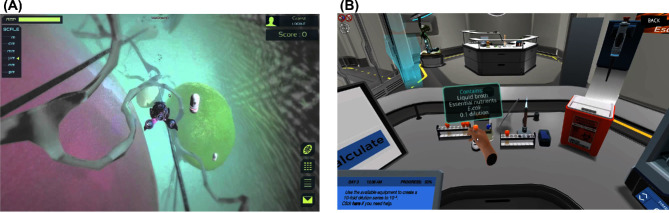
Gamified simulations for teaching cell biology and laboratory techniques. (A) Screenshot of Meta!Blast, a gamified simulation software that was designed to teach high school and college students about cellular biology. (B) Screenshot of Labster, a gamified simulation that allows students to complete a wide range of virtual labs online including medical genetics, microbiology, forensics and other laboratory techniques such as high-performance liquid chromatography (HPLC).